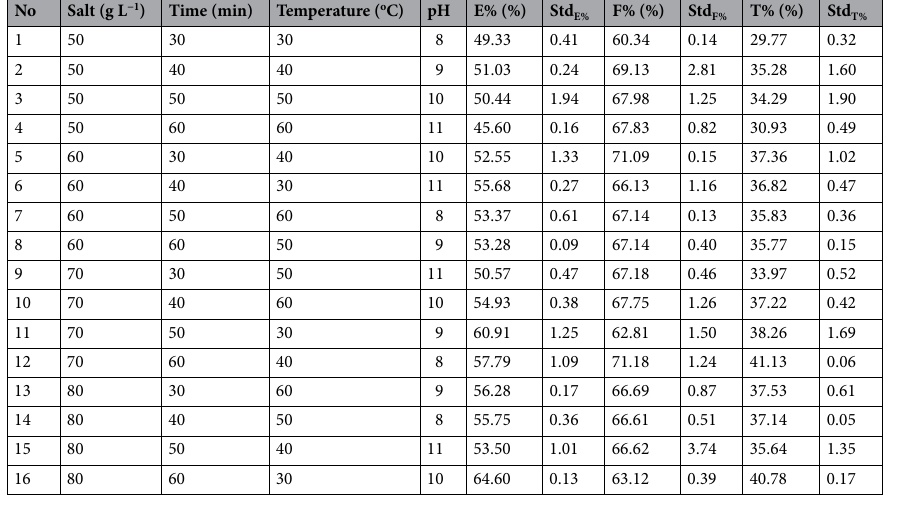
Table 2. E%, F%, and T% values of R2-dyed samples of traditional grass cloth in the L16 (4^4) orthogonal experimental scheme.